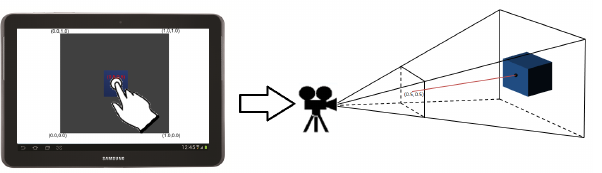
Figure 17. Symbolic Input: Annotation